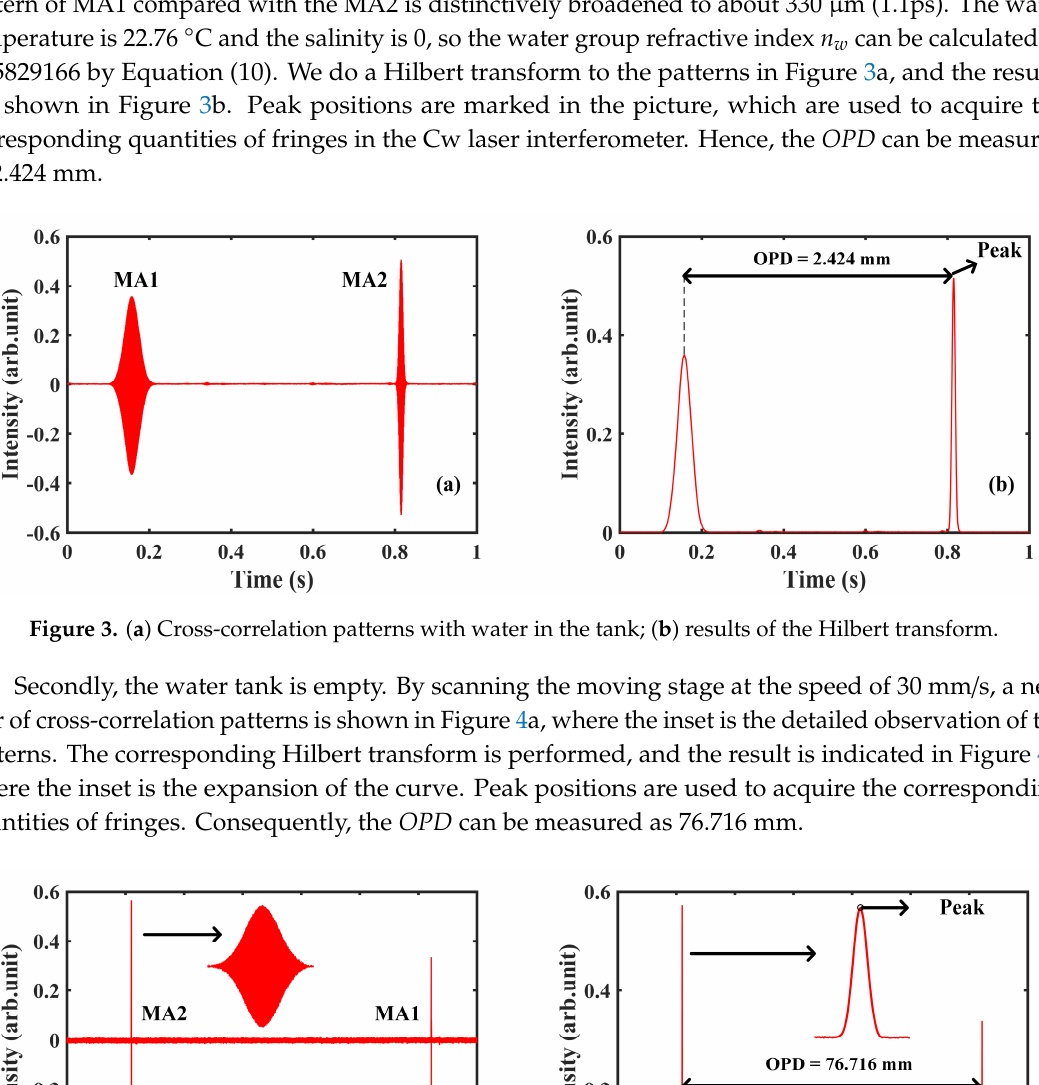
Figure 4. ( a ) Cross-correlation patterns without water in the tank; ( b ) results of the Hilbert transform.